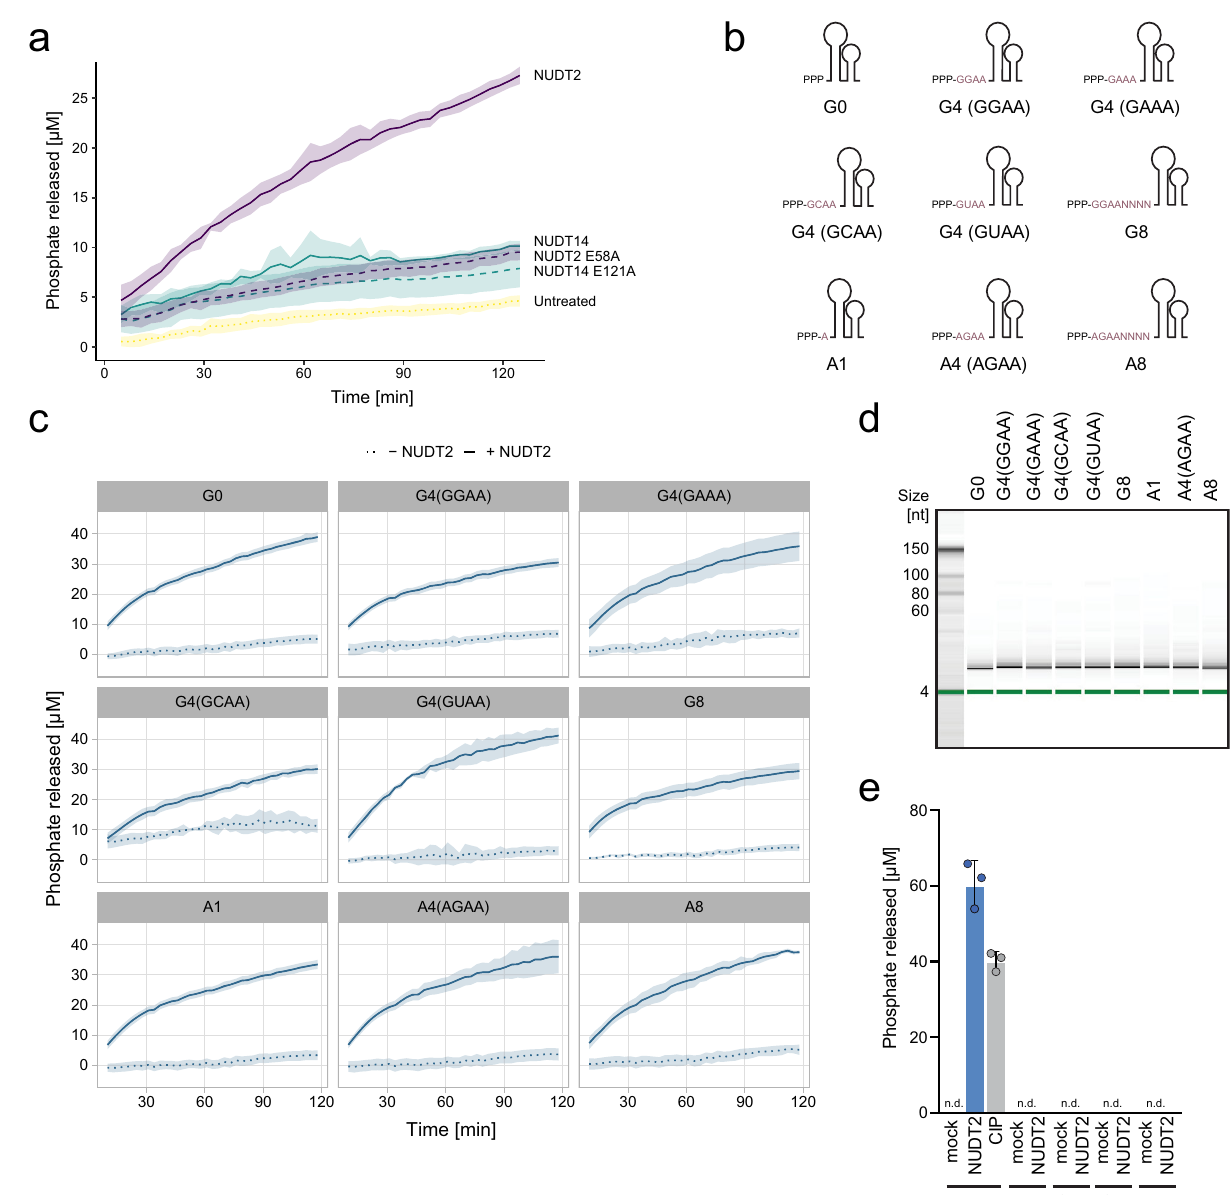
Fig. 3 NUDT2 is active on a broad range of substrates. a EnzChek assay to quantify released phosphate from in vitro transcribed double-stranded triphosphorylated hairpin RNA (IVT4) left untreated (untreated) or incubated with recombinant NUDT2, NUDT E58A, NUDT14, or NUDT14 E121A (600 nM), as indicated. Colorimetric measurements of the samples were performed every 3 min. The line graph shows the mean of three independent experiments with the ribbon indicating ± SD. b Illustration of in vitro transcribed RNA substrates with varying starting nucleotides with or without paired 5 ′ - overhangs. c RNA substrates depicted in ( b ) were incubated without (dotted line) or with (solid line) NUDT2 at a concentration of 600nM over a time course of 2 h, and phosphate release was evaluated using the EnzChek assay. Spectrophotometric measurements to quantify phosphate release were performed every 3 min. The line graph shows the mean of three independent experiments with the ribbon indicating ± SD. d The indicated RNA was incubated with NUDT2 (600 nM) for 3 h, and the integrity was analyzed using an Agilent small RNA chip and a Bioanalyzer. e The indicated ribonucleoside triphosphates (2.5 µ M) and the positive control IVT4 were incubated for 3 h with NUDT2 (600 nM), and phosphate release was determined by malachite green assay. The mean of three independent reactions ± SD is